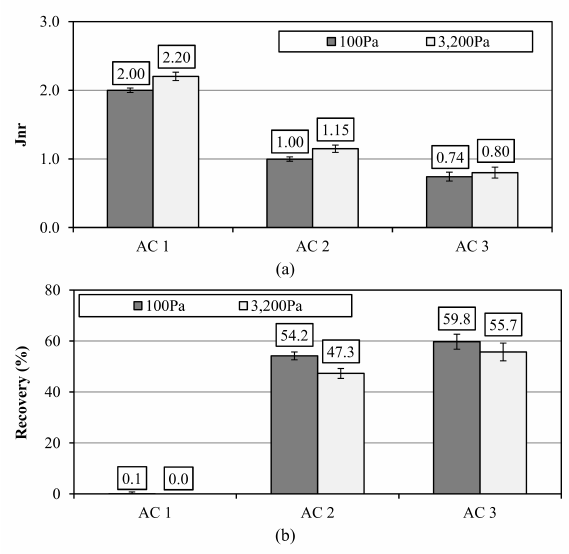
Figure 6: MSCR parameters at the PG temperatures: (a) Jnr and (b)